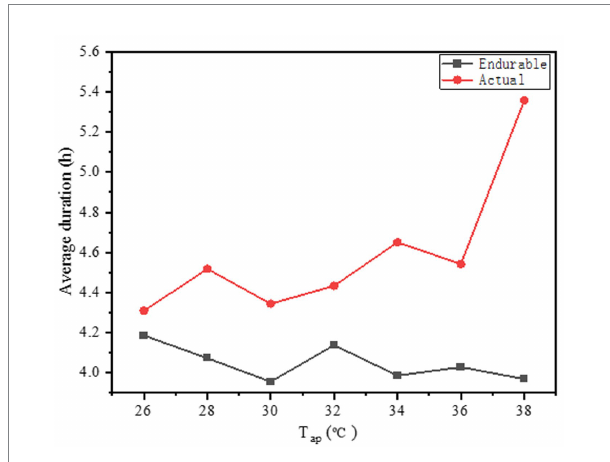
FIGURE 10 Variations in the average duration of wear PPE against T a